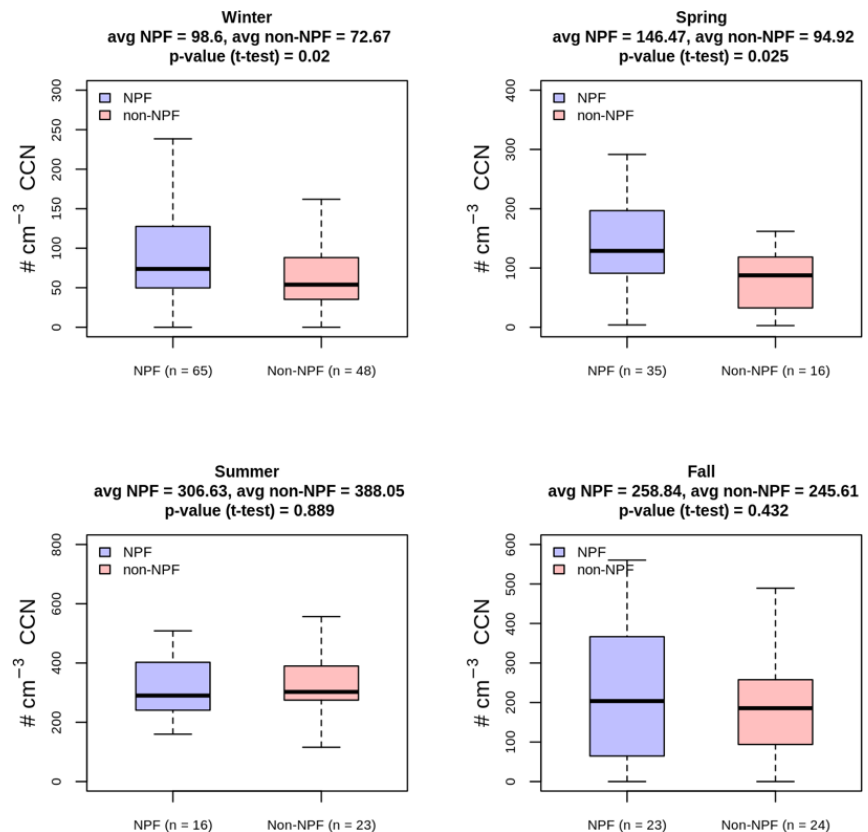
Figure 5. Seasonal comparisons of average CCN number concentrations (cm − 3 ) during NPF events (blue) and non-events (red). CCN concentrations during events are considered starting at the CCN start time and ending at the CCN end time of a given day. CCN is considered during non-events starting at the seasonal average of CCN start and ending at the seasonal average of CCN end . Displayed p values represent the results of a two-sample t test with a one-sided hypothesis that NPF days would exhibit greater CCN concentrations than non-events. We interpret values below p = 0 . 05 to be statistically significant. p values show that the spring and winter display statistically significant enhancements of CCN due to NPF, a trend that is absent during the summer and